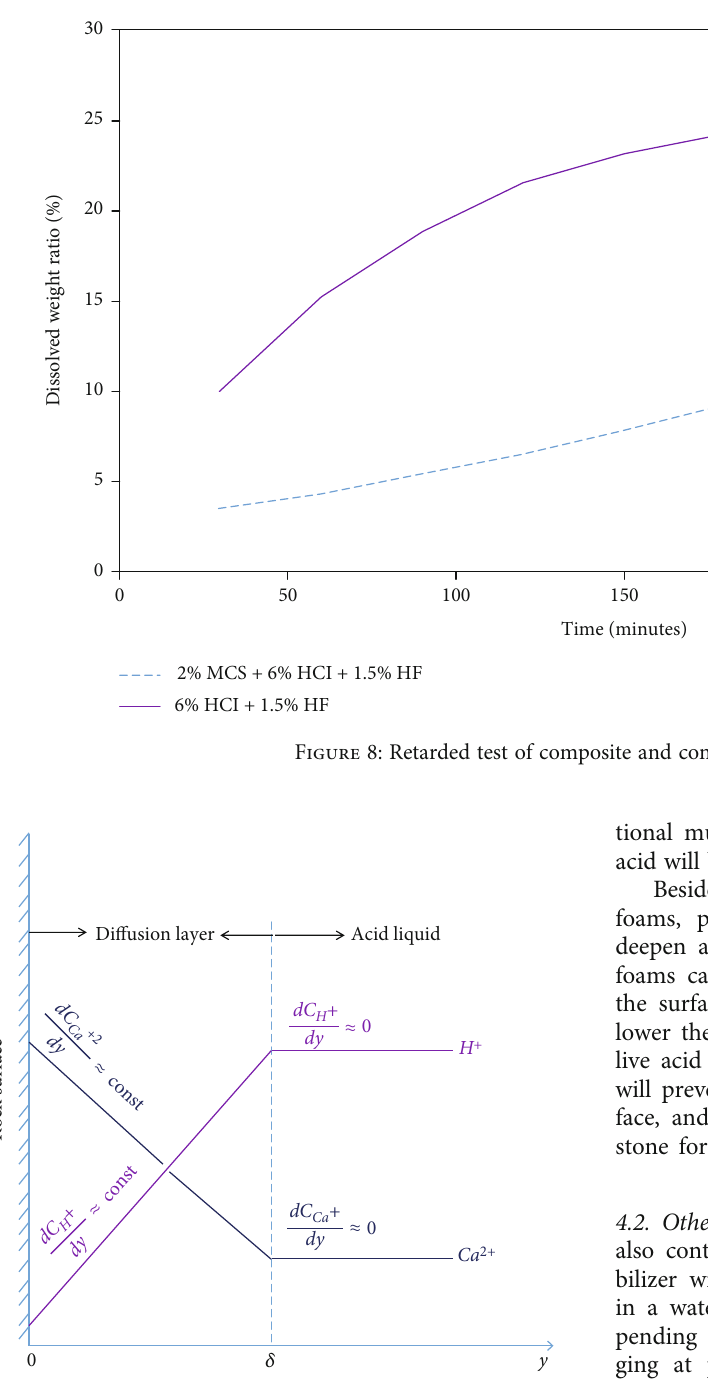
Figure 9: Concentration distribution in di ff usion layer for acid- rock